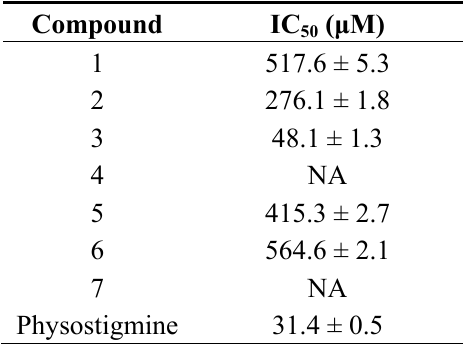
Table 2 . Acetylcholinesterase inhibitory activity (IC